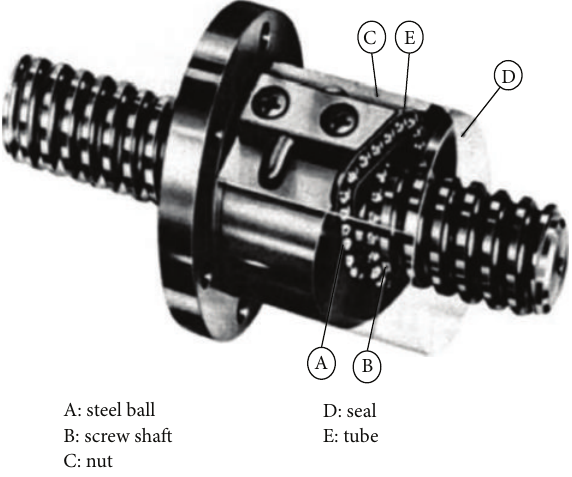
Figure 1: Structure of ball-screw.